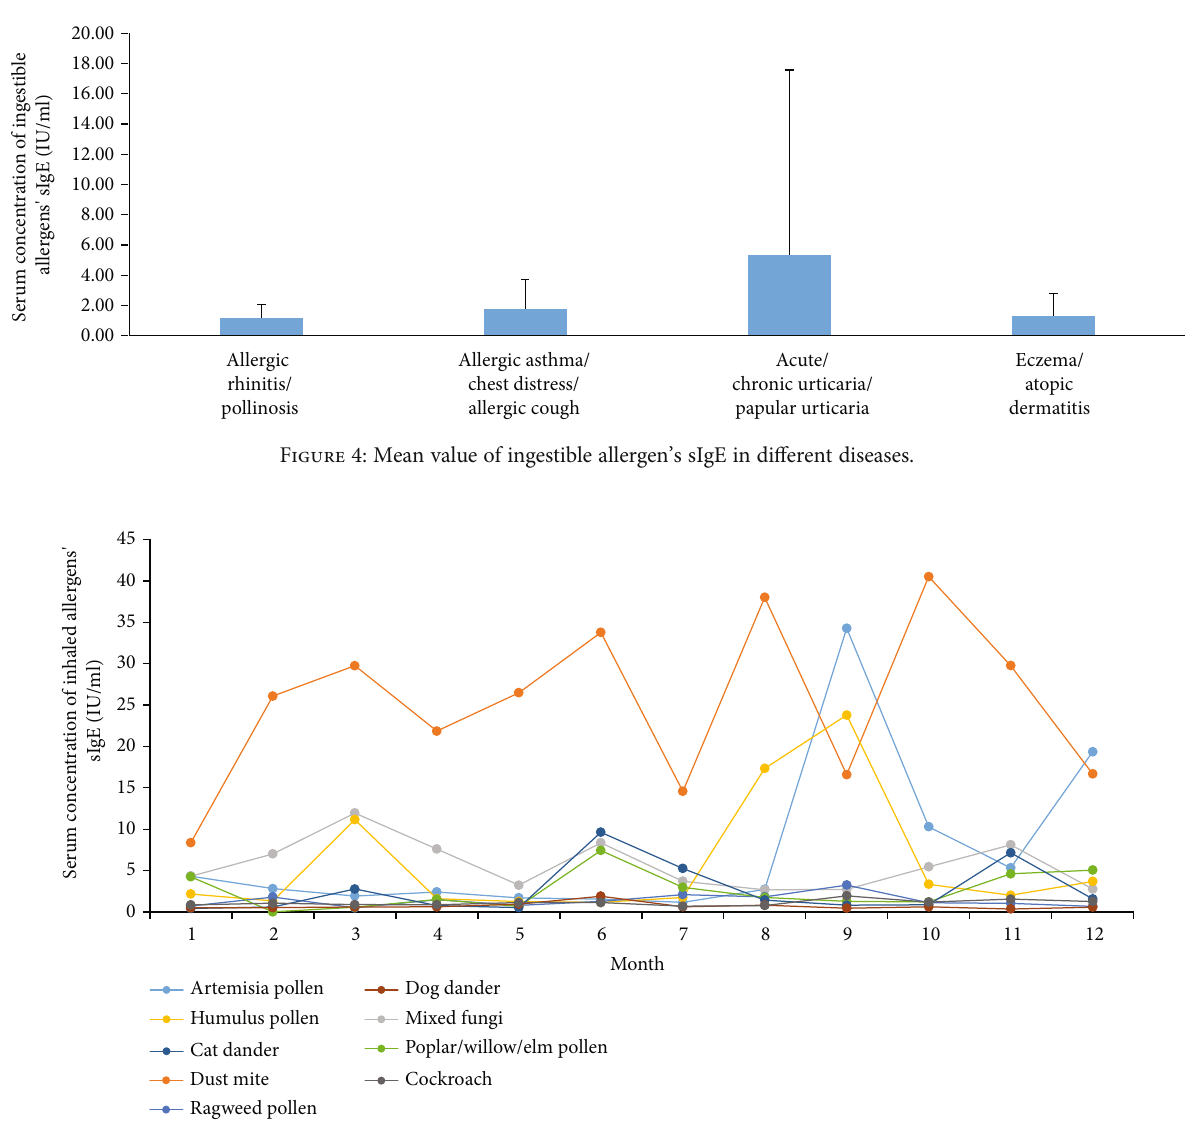
Figure 5: sIgE levels of 9 inhaled allergens in di ff erent